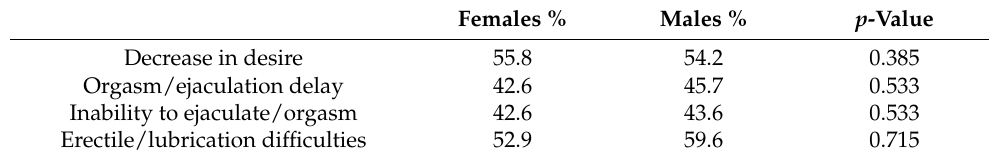
Table 2. Frequency of sexual dysfunction in the global sample. SALSEX questionnaire (items 1, 2, 3 and 4).